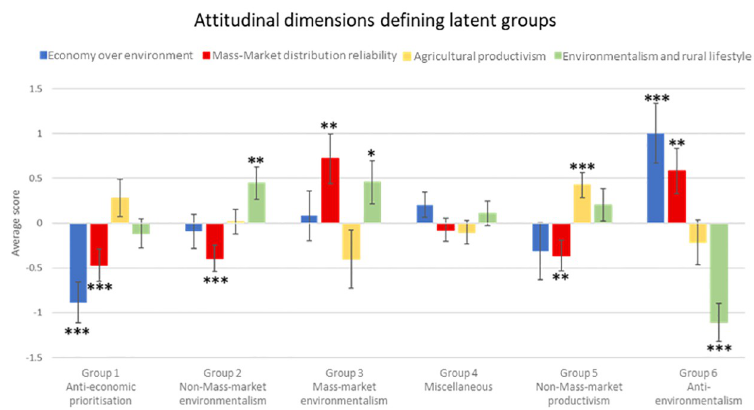
Fig 2. Different social groups formed in the latent-class model from the attitudinal dimensions. Scores indicate the contribution of each attitudinal factor to the different latent social groups. Black stars refer to trends (90%, 1 star) and significant attitudes defining social groups (95% and 99% for 2 and 3 stars, respectively). For more detailed statistical results, see A1 Table in S1 Appendix.